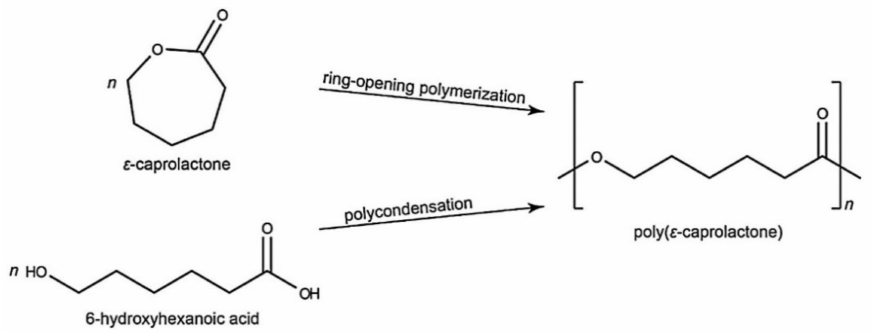
Figure 9. Scheme of the synthesis of PCL from ε -CL and hydroxyhexanoic acid. Reprinted with permission from Elsevier